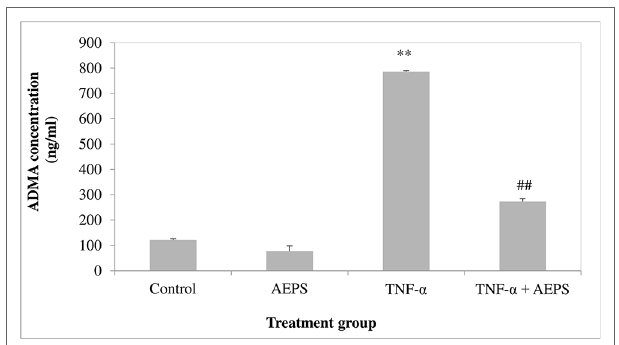
FIGURE 6 | Asymmetric dimethylarginine (ADMA) concentration in human umbilical vein endothelial cells (HUVEC). Data shown as mean ± SEM, n = 6 [** P < 0.01 compared with THE control group, ## P < 0.01 compared with the tumor necrosis factor (TNF)- α group].